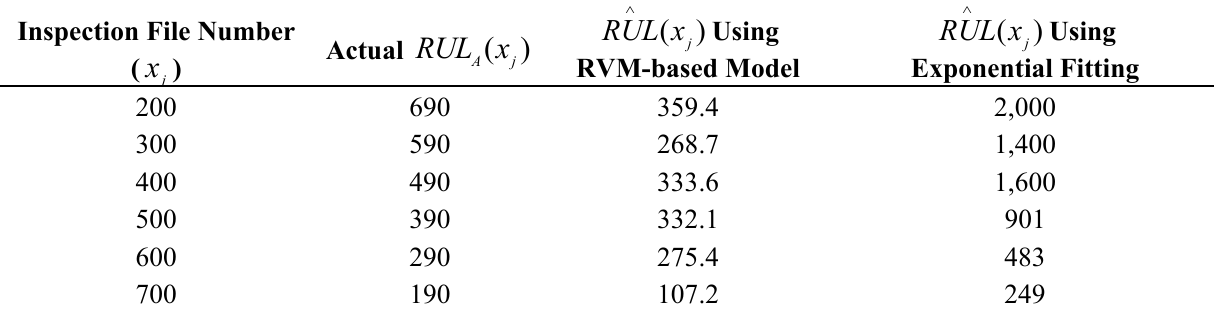
Table 2. Values of using the RVM-based model and exponential fitting.